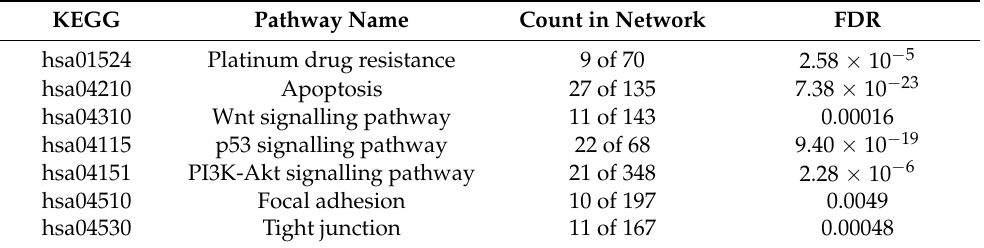
Table 3. Major dysregulated KEEG pathways. FDR—falls detection rate < 0.05; p value of <